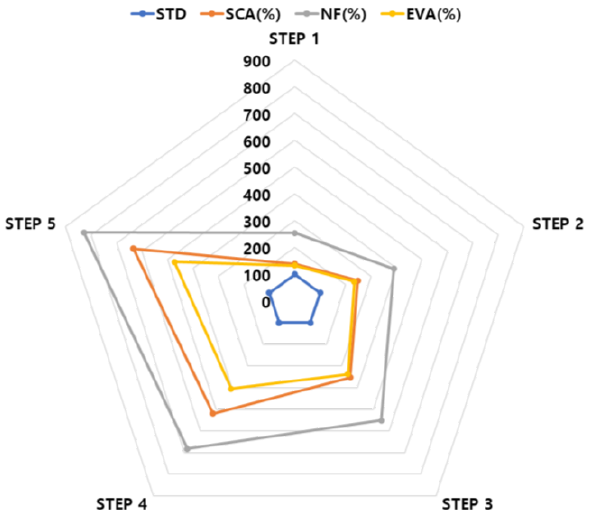
Figure 12. Increase/decrease rate of solid content according to the input amount of each additive.